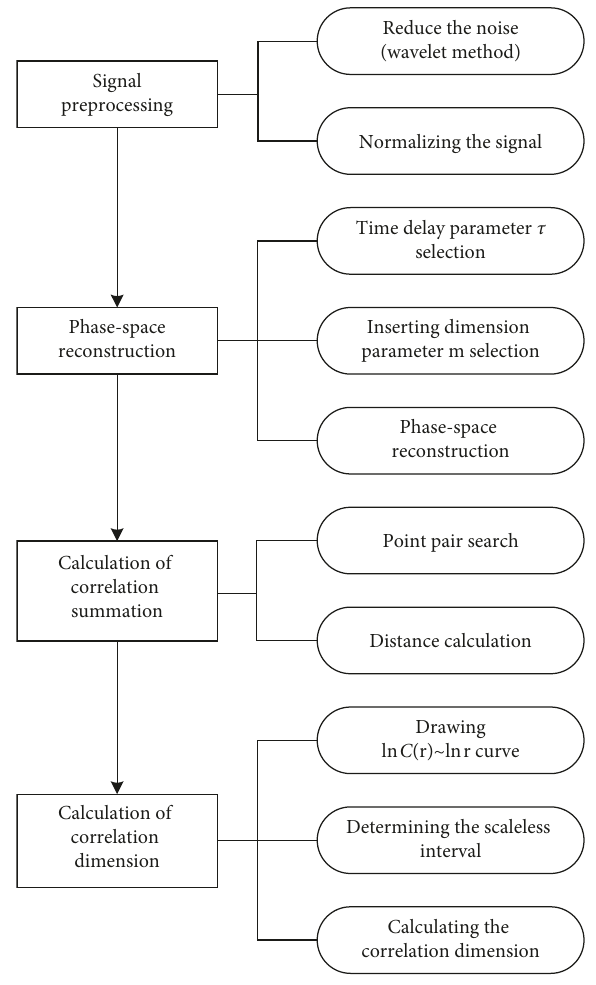
Figure 3: Calculation process of correlation